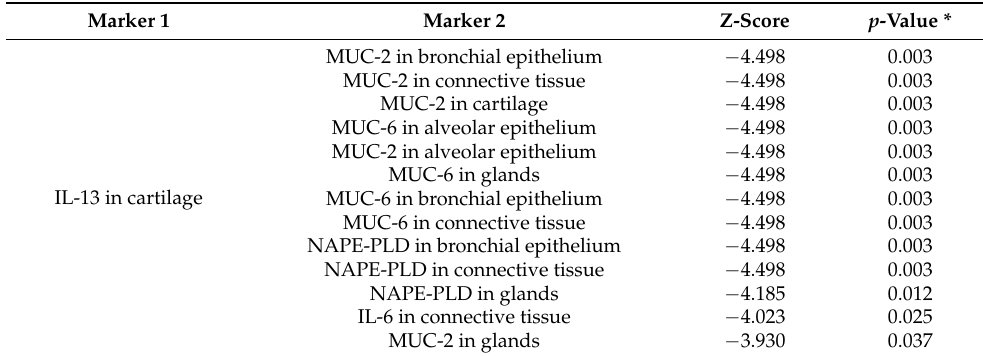
Table 4. Friedman test with pairwise comparison revealing statistically significant difference between different factors and different tissue locations in the pseudostratified ciliated epithelium group.